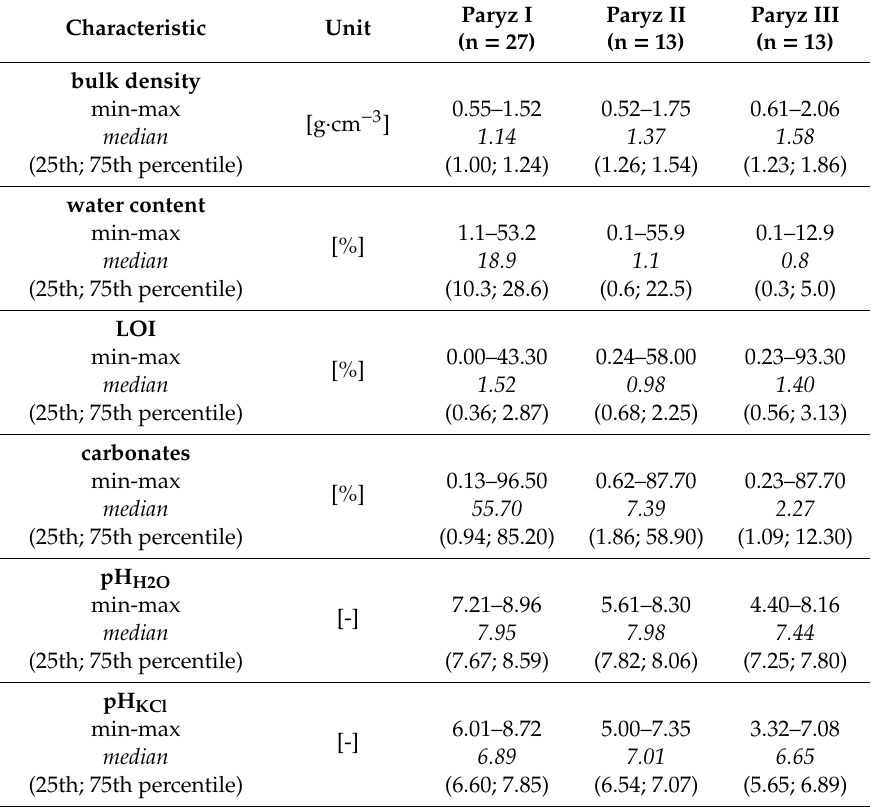
Table 2. The soil characteristics in profiles from the Paryz